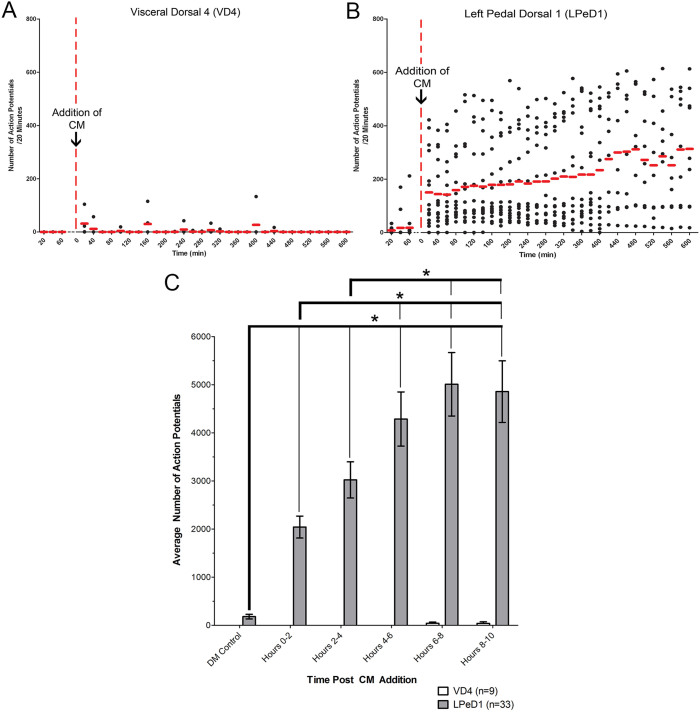
LPeD1 and VD4 activity in 20 minute and 2 hour bins following exposure to CM.Neuronal activity is shown as observed over a 10 hour period using microelectrode arrays. VD4 and LPeD1 neurons were cultured on the microelectrode arrays in DM (without trophic factors) overnight, and CM (with trophic factors) was added the next day following 2 hours of control DM recordings. Activity from (A) VD4 and (B) LPeD1 isolated neurons is shown in the scatterplot with the red line designating the mean number of action potentials for 20 minute bins. The activity was then (C) further binned into two hour periods for both VD4 and LPeD1 neurons and a one-way ANOVA showed significant differences at different time periods, with a maximal activity plateau reached between 5–10 hours. Note a rapid rise in activity in LPeD1 following CM addition as compared to that observed in VD4, which did not exhibit a similar response. Significant differences are denoted with an asterisk (*) and significance was assumed if p < 0.05.